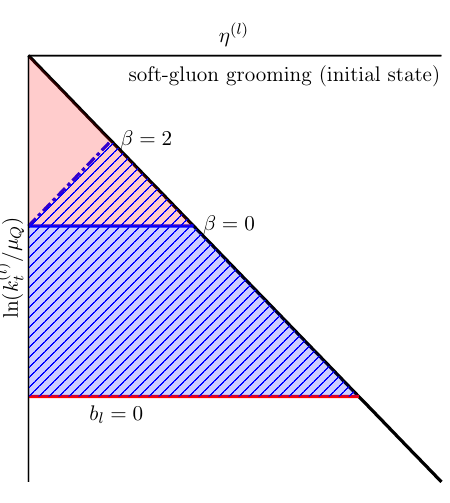
Figure 18 . The Lund diagram showing the kinematic constraints for soft drop applied to initial- state emissions. As examples a l = 1 with b l = 0 and β = 0 (solid line and area) and β = 2 (dashed line, hatched area) are